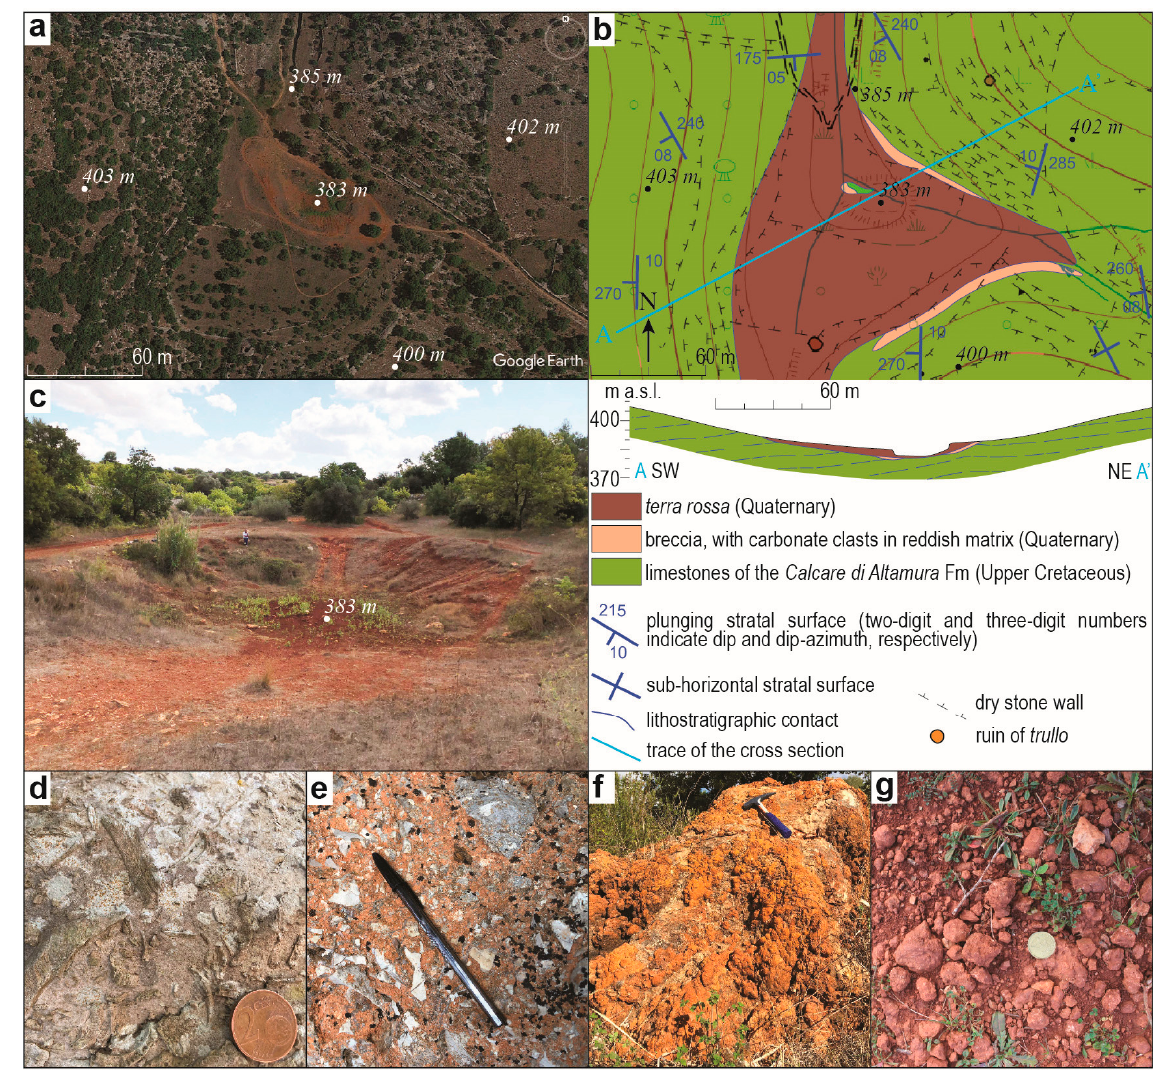
Figure 2. ( a ) Satellite image of the study area (Figure 1c for location); the geographic coordinates of the minimum elevation (383 m a.s.l.), at the bottom of the morphologic depression, are 40°53 ′ 02.70 ″ N, 16°44 ′ 48.88 ″ E; ( b ) Geological map of the study area and cross-section; ( c ) View of the small basin within the terra rossa , at the bottom of the morphological depression; ( d ) Detail of a wackestone rich in rudist fragments of the Calcare di Altamura Fm; ( e ) Detail of the breccia, with carbonate clasts in a reddish matrix; ( f ) Detail of the incrustations on a limestone block; ( g ) Reddish nodules in the fine-grained terra rossa .